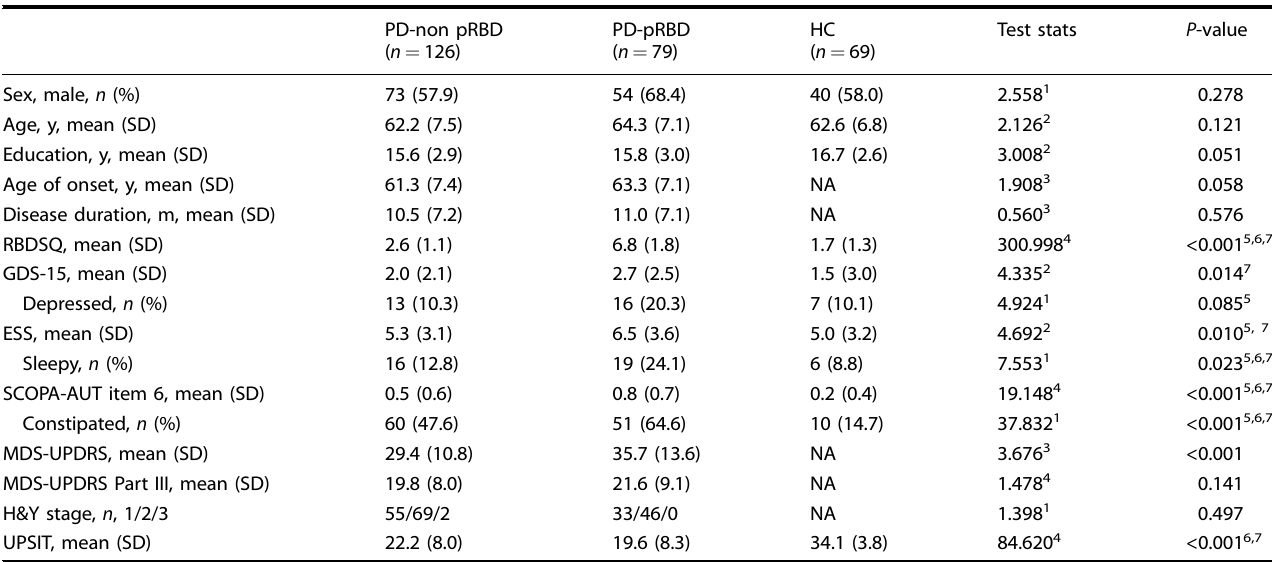
Table 1. Demographic and clinical characteristics of PD-non pRBD, PD-pRBD, and